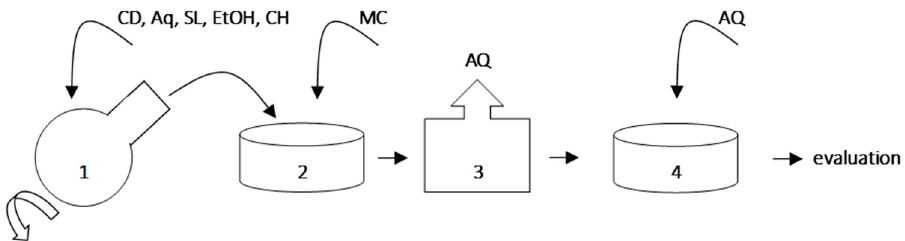
Figure 1. Overall procedure of samples preparation: CD—calcium dobesilate, MC—methylcellulose,